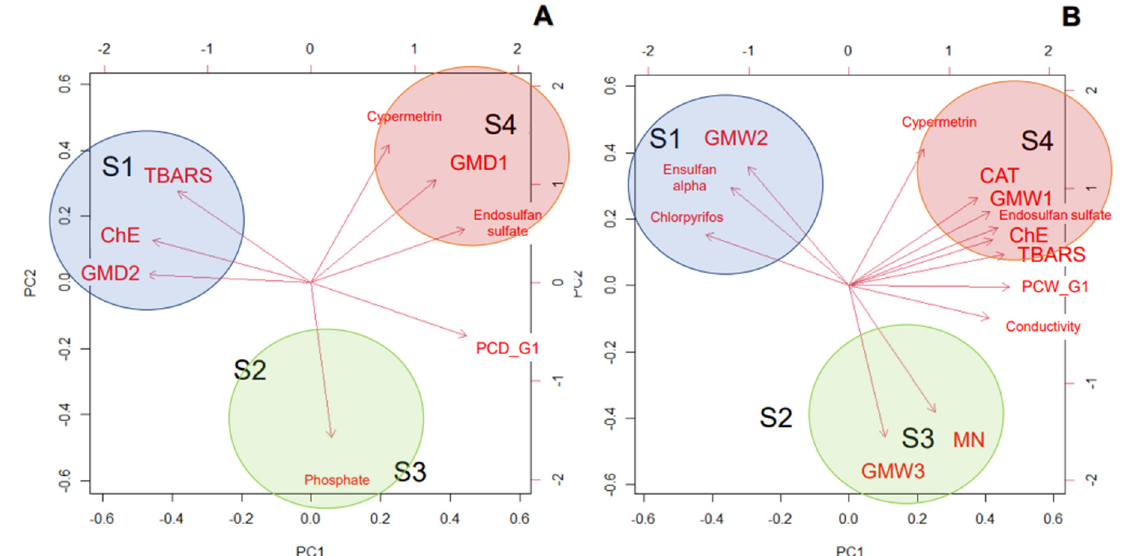
Figure 5. Biplot showing the differences among four sites in the Conlara River (Paso Grande—S1, Renca—S2, Concarán—S3, and Santa Rosa del Conlara—S4) due to physicochemical parameter, metal and pesticide contamination for the dry season ( A ) and the wet season ( B ). For the dry season, the variables are named as follows: GMD1 corresponds to arsenic and magnesium metals; GMD2 corresponds to cadmium, copper, barium, and lead metals, and; PCD_G1 corresponds to physico- chemical variables correlated such as pH, conductivity, nitrate, nitrite, ammonia, total hardness, organic matter, dissolved oxygen, and DQO. For the wet season, the variables are named as follows: PCW_G1 corresponds to physicochemical variables correlated such as pH, nitrate, nitrite, ammonia, phosphate, total hardness, organic matter, and dissolved oxygen; GMW1 corresponds to arsenic and lead metals; GMW2: corresponds to chromium and zinc metals, and; GMW3 corresponds to iron and barium. The blue, red, and green circles represent the variables associated with Paso Grande (S1), Renca and Concarán (S2 and S3), and Santa Rosa del Conlara (S4), respectively.